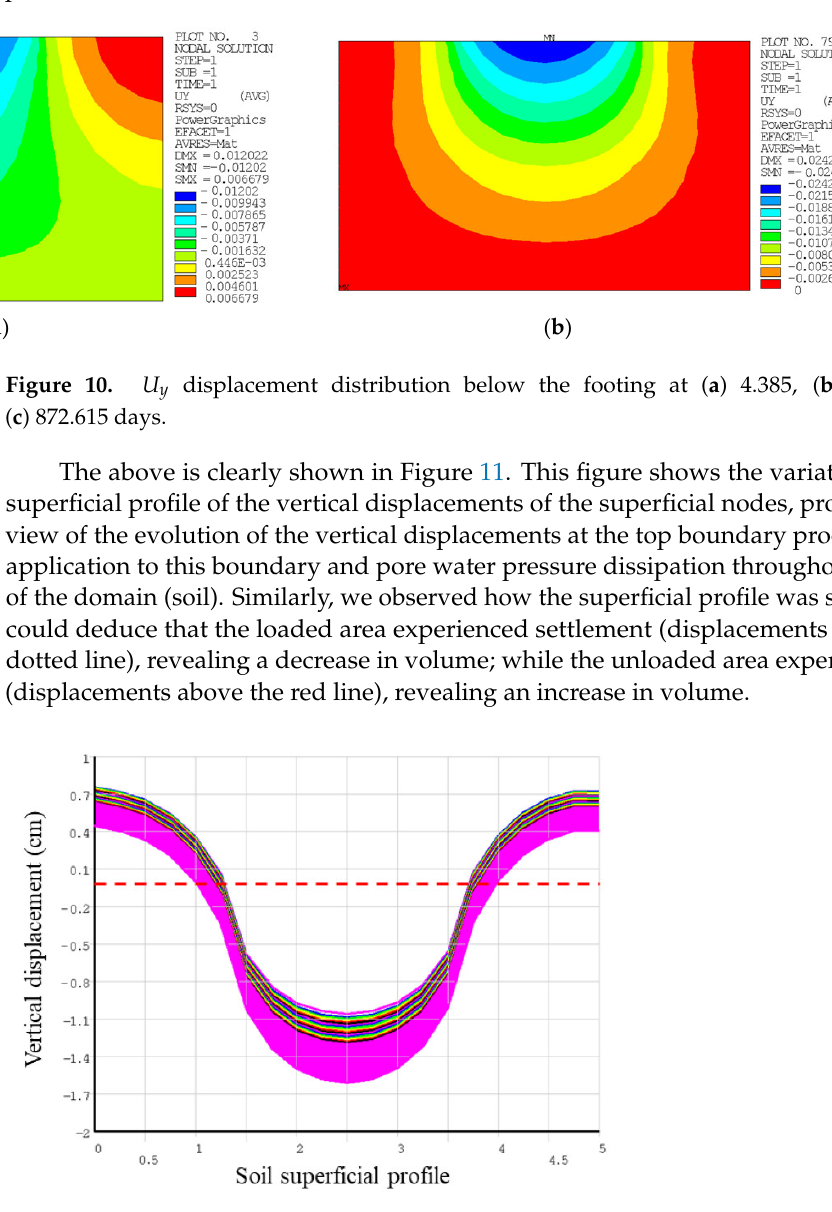
Figure 11. Soil superficial profile of the vertical displacements of the superficial nodes.